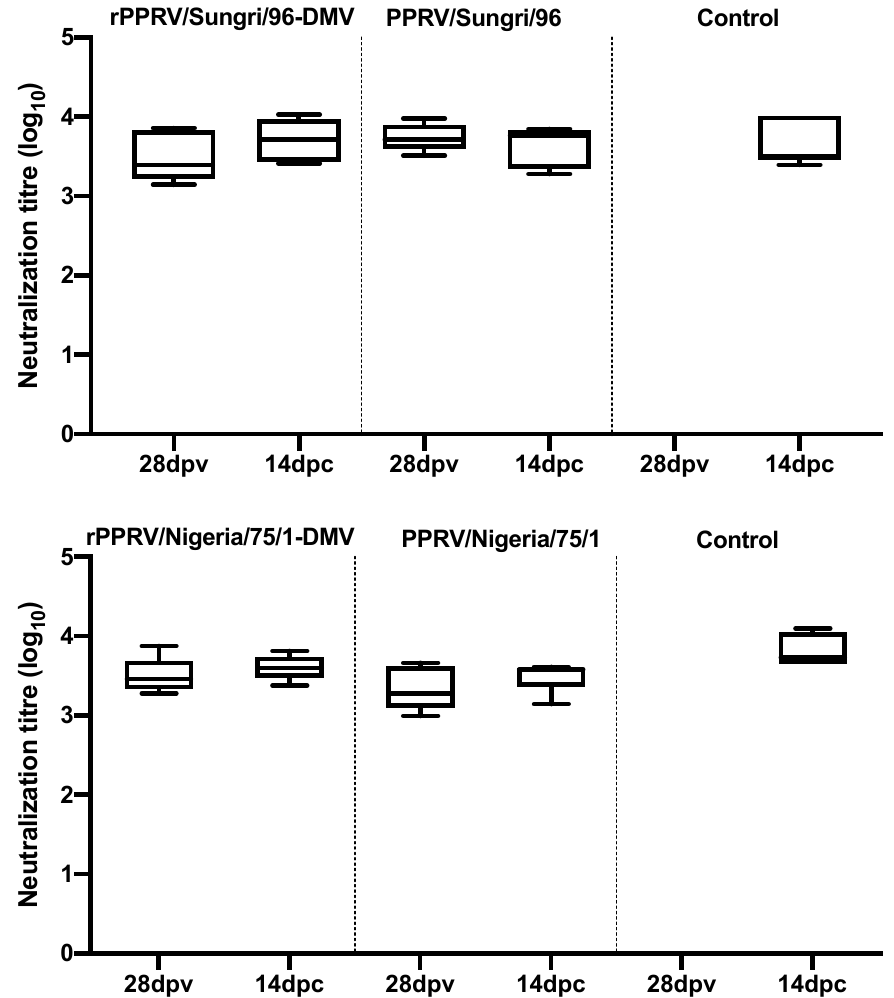
Figure 6. The antibody response in goats to PPRV vaccines; dpv: days post-vaccination; dpc: days post-challenge The neutralizing titers of the sera collected on 28 dpv and 14 dpc were determined against the Nigeria/75/1 and Sungri/96 vaccine viruses. The data are presented as box-and-whisker plots, in which the bars span the minimum and maximum values, and the box shows the range from the first to the third quartile. The central horizontal line in each box shows the median value. The 14 dpc control group data are from 2 and 4 animals in the Sungri/96 and Nigeria/75/1 experimental groups, respectively.